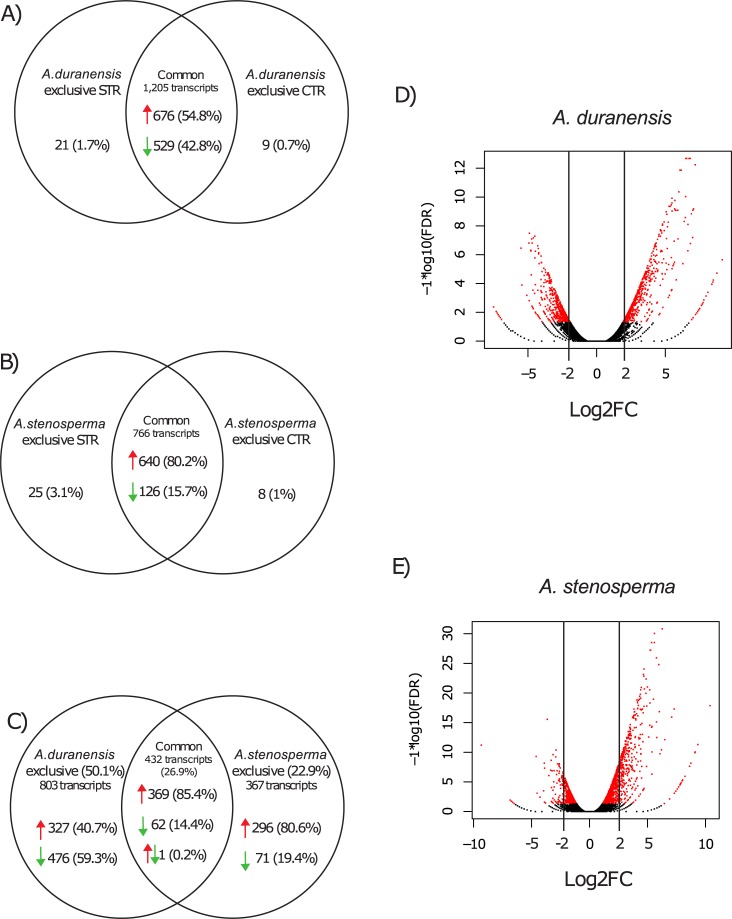
Expression patterns of Arachis spp. transcripts in response to dehydration.Venn diagrams showing the number of common and exclusive Differentially Expressed Genes (DEGs) in STR and CTR libraries of A. duranensis (A); A. stenosperma (B); and in both species (C). STR indicates the library from stressed (T25 to T150) samples and CTR the library from control (T0) samples. Red arrows indicate DEGs significantly upregulated during dehydration and green the downregulated DEGs. Volcano plots showing the comparison of gene expression profiles between STR and CTR samples in A. duranensis (D) and A. stenosperma (E), with each gene represented by one dot (DEGs in red and not significant in black).